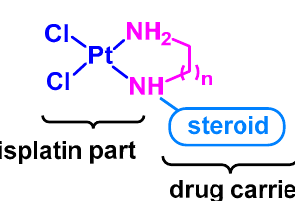
Figure 1. General model of steroid-based cisplatin derivatives (n = 1 or 2).